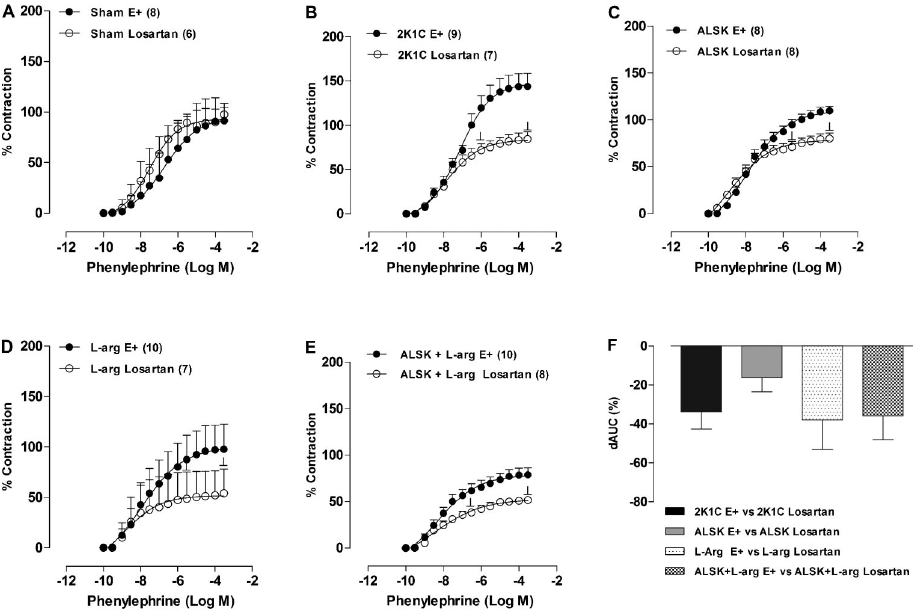
Figure 5. Effects of losartan (10 mM) on the concentration-response curves to phenylephrine in endothelium-intact aortic segments from Sham ( A ), 2K1C ( B ), aliskiren (ALSK) ( C ), L-arginine (L-arg) ( D ), and ALSK++L-arg ( E ) treatments in aortic rings in the presence (losartan) and absence (E++) of losartan blocker. The differences in the area under the concentration-response curves (dAUC) in the presence and absence of losartan are shown in F . The number of animals in each group is indicated in parentheses. H P , 0.05 vs E++ (two-way ANOVA, followed by Tukey’s post hoc